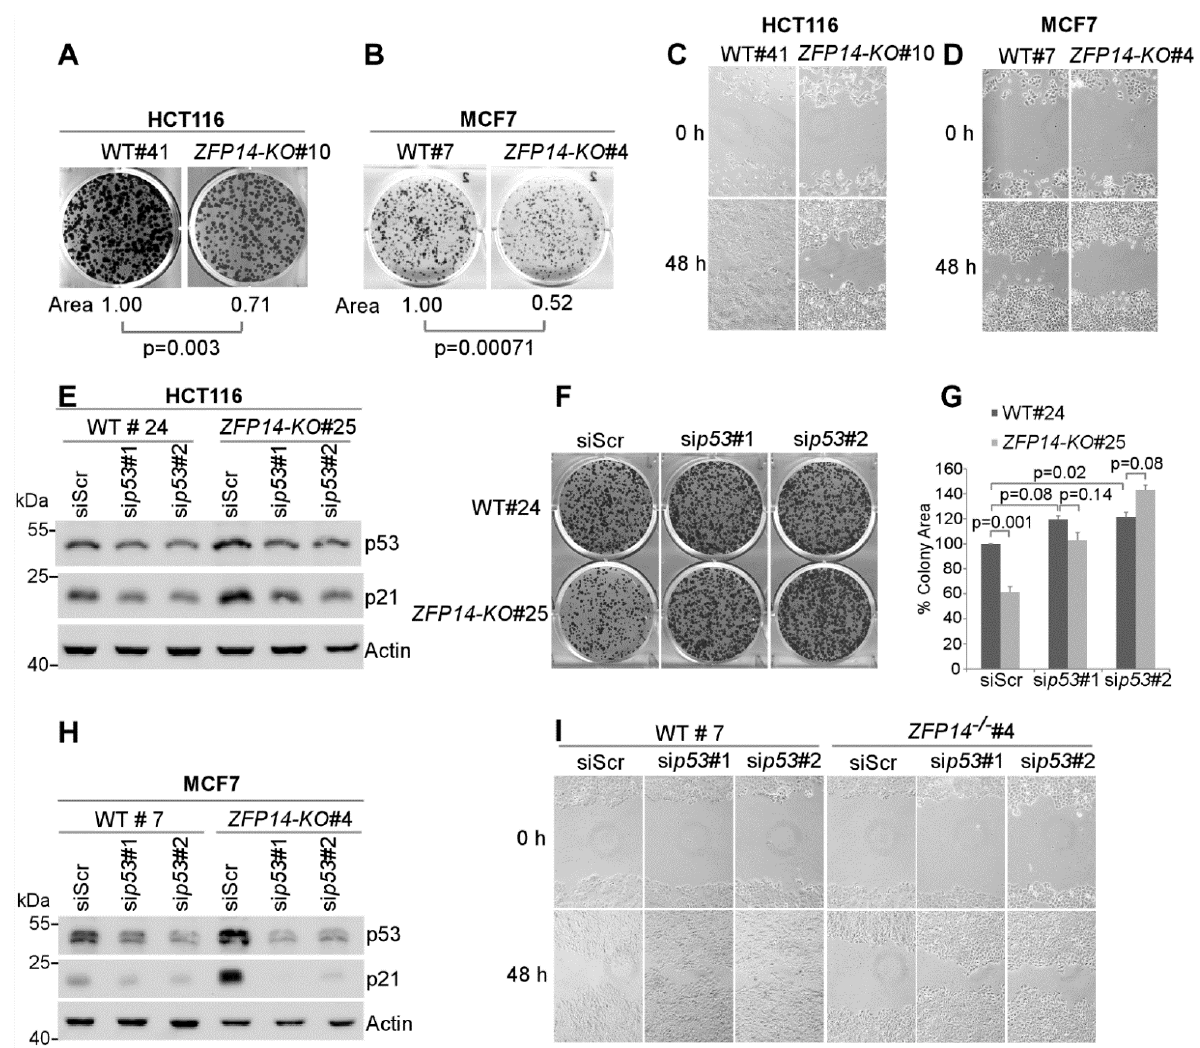
Figure 5. Decrease in cancer cell growth and migration upon ZFP14 KO is p53 ‐ dependent. ( A , B